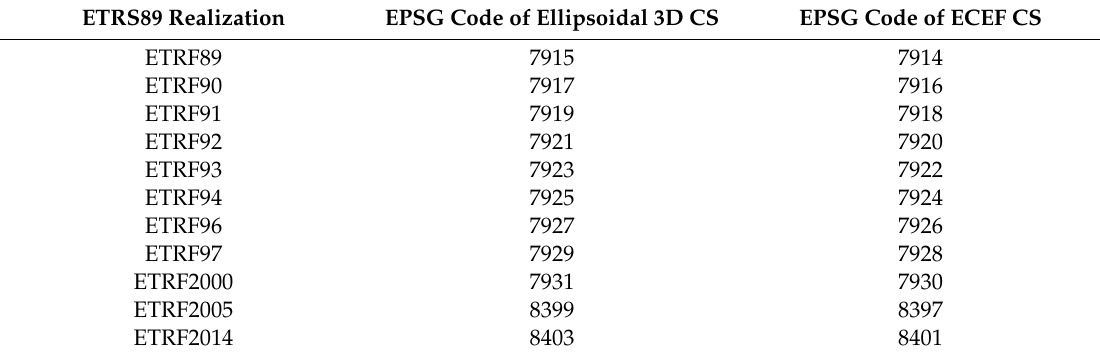
Table 2 lists the EPSG codes of ellipsoidal three-dimensional and ECEF coordinate systems of o ffi cial ETRS89 realizations [6]. Table 2. List of EPSG codes of European Terrestrial Reference System 1989 (ETRS89)